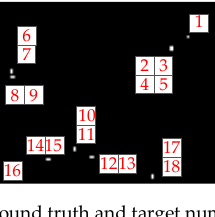
Figure 8. Total data, selected region and generated sub-pixel anomalies on Dataset-1 and Dataset-2. ( a1 , a2 ) Denote false color image of each data. ( b1 , b2 ) Denote false color image of the selected regions. ( c1 , c2 ) Denote generated sub-pixel anomalies with different abundance ratios.